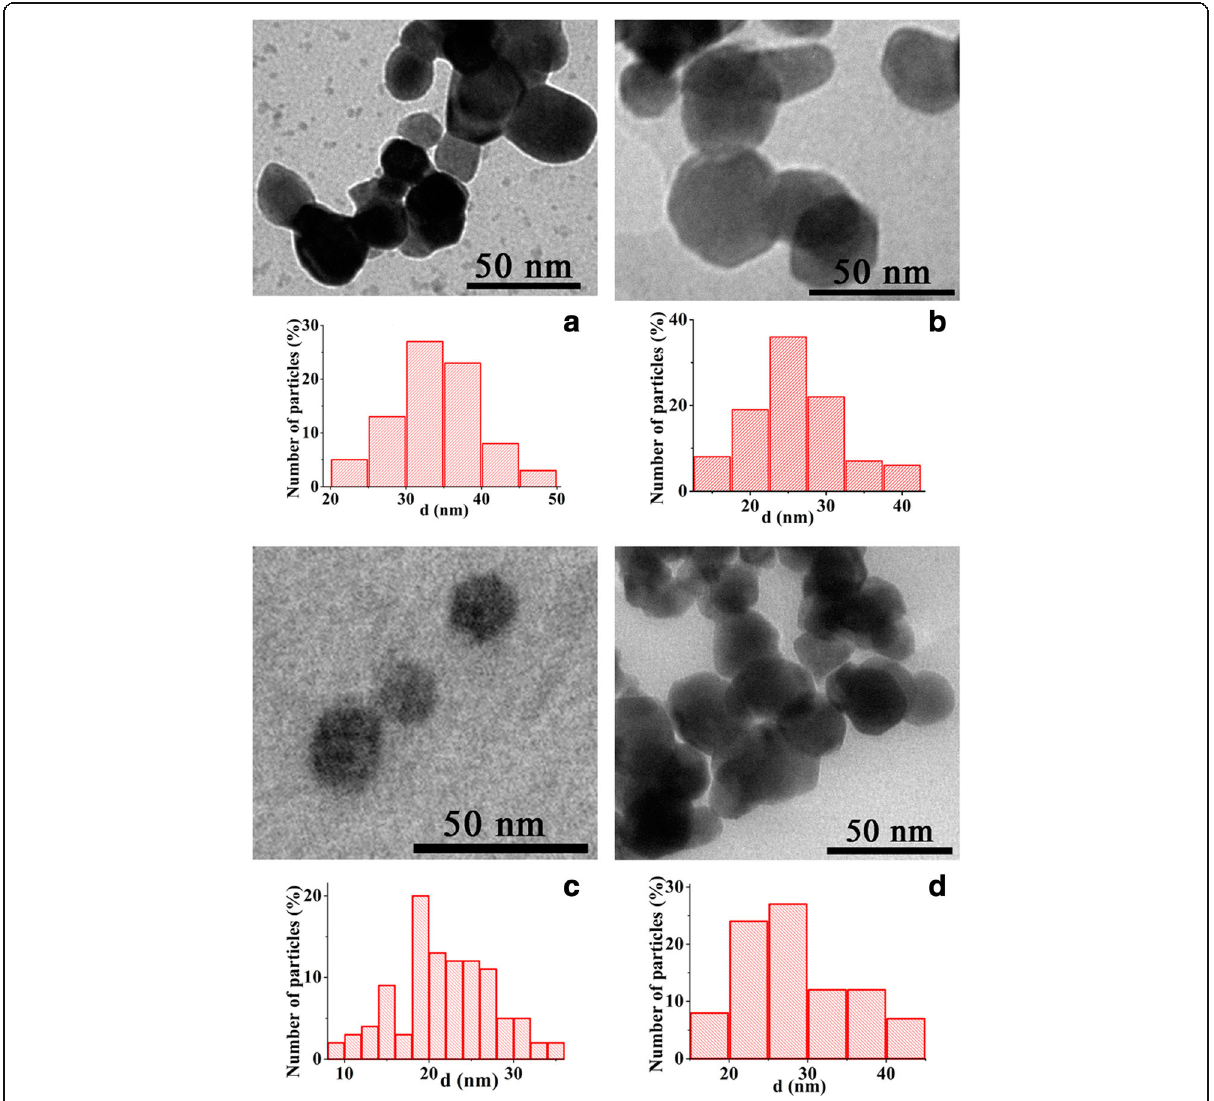
Fig. 2 TEM images and particle size distributions of LSMO nanoparticles synthesized via sol-gel method ( a ), by precipitation from DEG solution ( b ), and by precipitation from reversal microemulsions based on Triton X-100 ( c ) and CTAB ( d